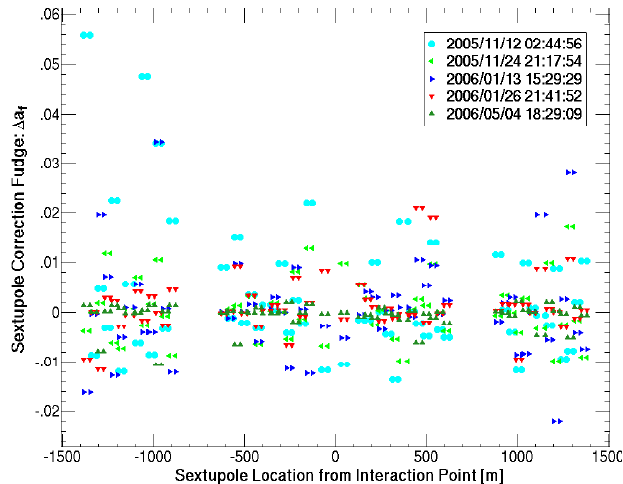
FIG. 4. (Color) Distribution of sextupole correction fudge ( 4 a ) obtained from the measurement. The horizontal axis shows f the position of the corrector sextupole described by the distance from the interaction point (IP) along the design orbit. The vertical axis shows the correction factor for the a the sextupole power supply at the individual off-momentum corrections. The 5 kinds of symbols correspond to the off- momentum corrections performed at 5 different times.